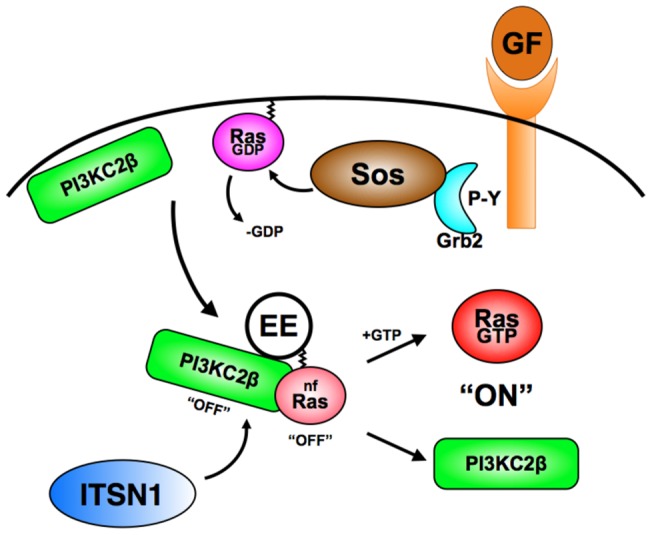
Model for ITSN1-Ras-PI3KC2β pathway.Growth factor stimulation of receptor tyrosine kinases leads to the recruitment of the Grb2-Sos complex resulting in dissociation of GDP from Ras. We propose that PI3KC2β competes for binding this transient nucleotide-free (nf) Ras trapping it in the nucleotide-free state and preventing GTP loading. In addition, binding of nucleotide-free Ras to PI3KC2β inhibits its lipid kinase activity. The PI3KC2β-Ras complex may then translocate to distal sites such as early endosomes (EE) where ITSN1 then binds to PI3KC2β leading to the release of nucleotide-free Ras and activation of the lipid kinase activity of PI3KC2β. In addition, once released from the ITSN1-PI3KC2β complex, Ras binds GTP resulting in Ras activation and recruitment of effectors, e.g., Raf, Class I PI3Ks, etc. Although the above model describes a potential role for nf-Ras in ITSN1 and PI3KC2β function, we propose that nf-Ras may be regulated by additional proteins besides these molecules. Our findings also raise the possibility that the nucleotide-free forms of other GTPases may play a similar role in cell signaling.